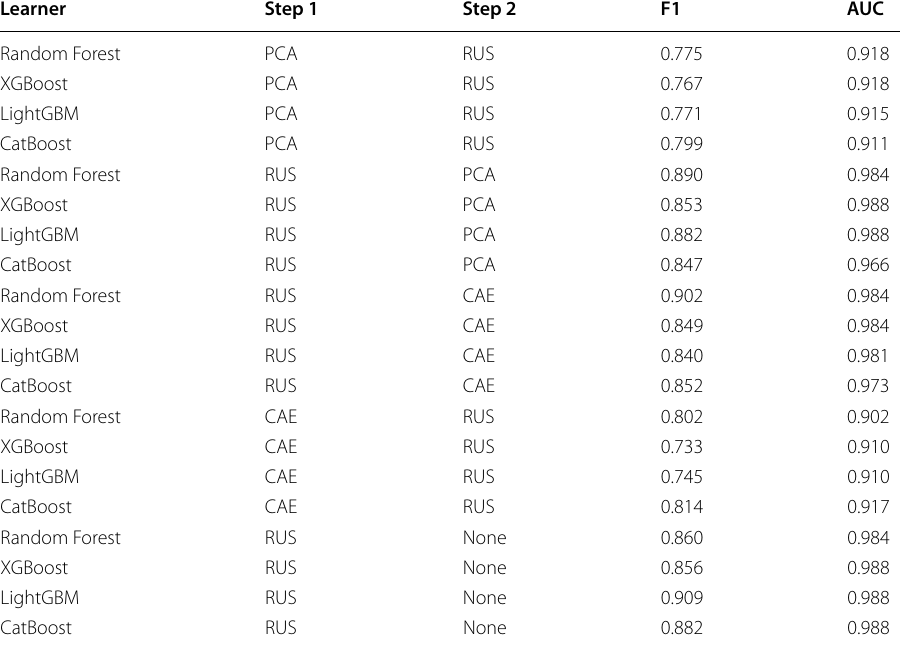
Table 7 Performance scores for RUS (1:50 ratio)